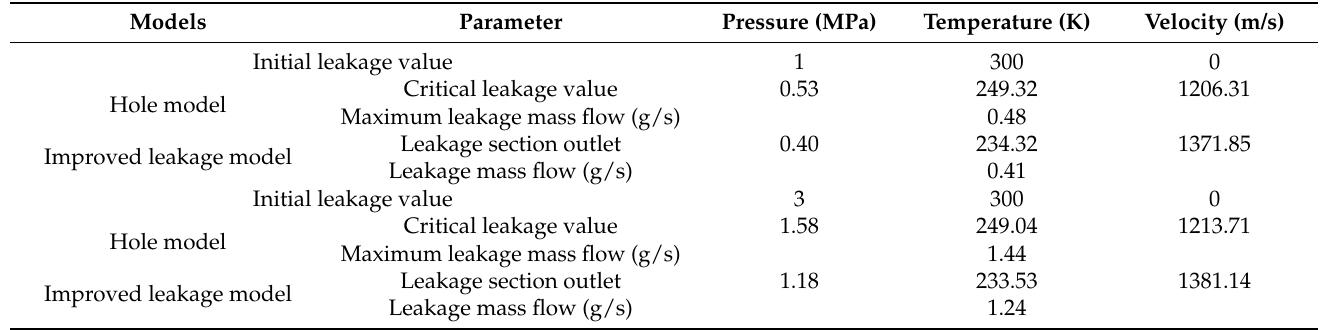
Table 4. Leakage gas state parameters obtained from the hole model and the improved leakage